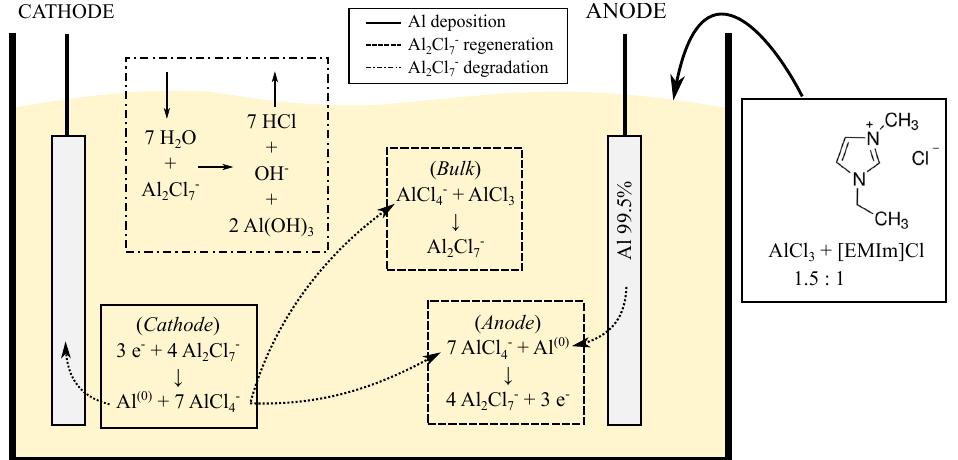
Figure 1. Schematics of the electrolyte used in this study and the Al electroplating process from ionic